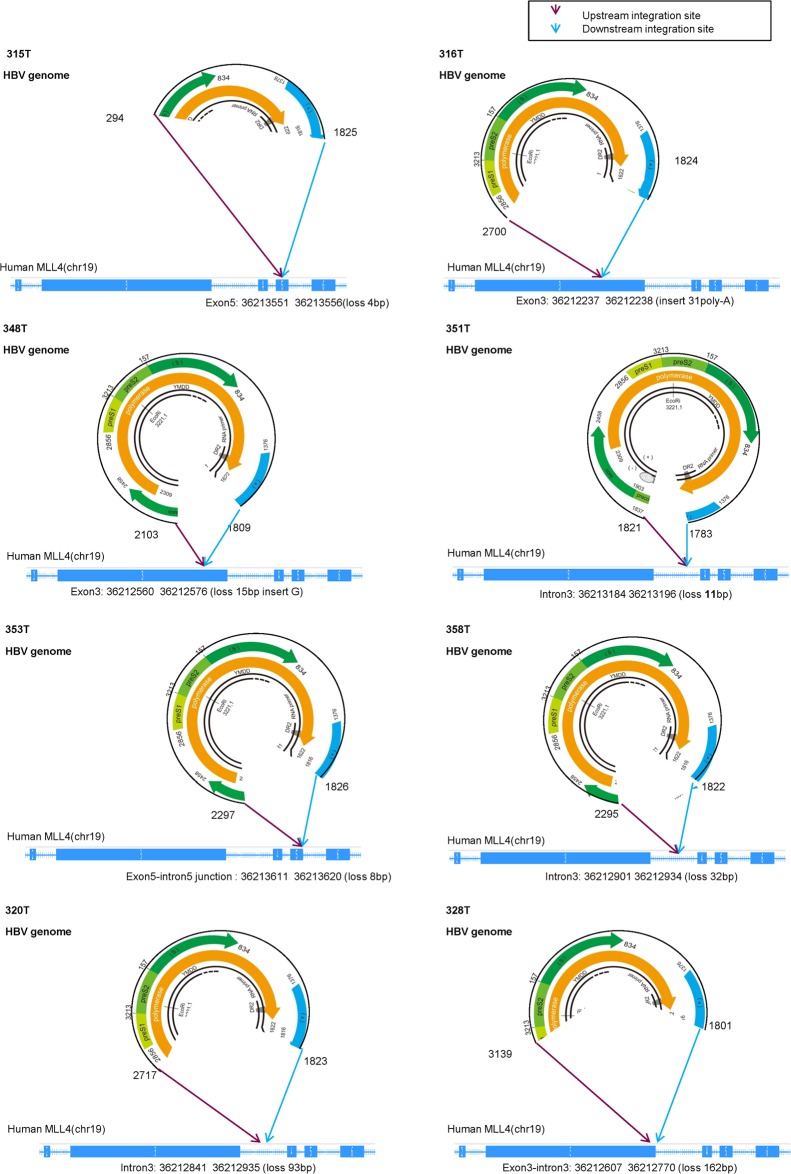
Genomic structures of HBV integration.HBV insertions are shown as circles marked with insertion positions. MLL4 insertion sites are marked as purple (upstream) and blue arrows (downstream), noted with the exact integration position on human gene MLL4.